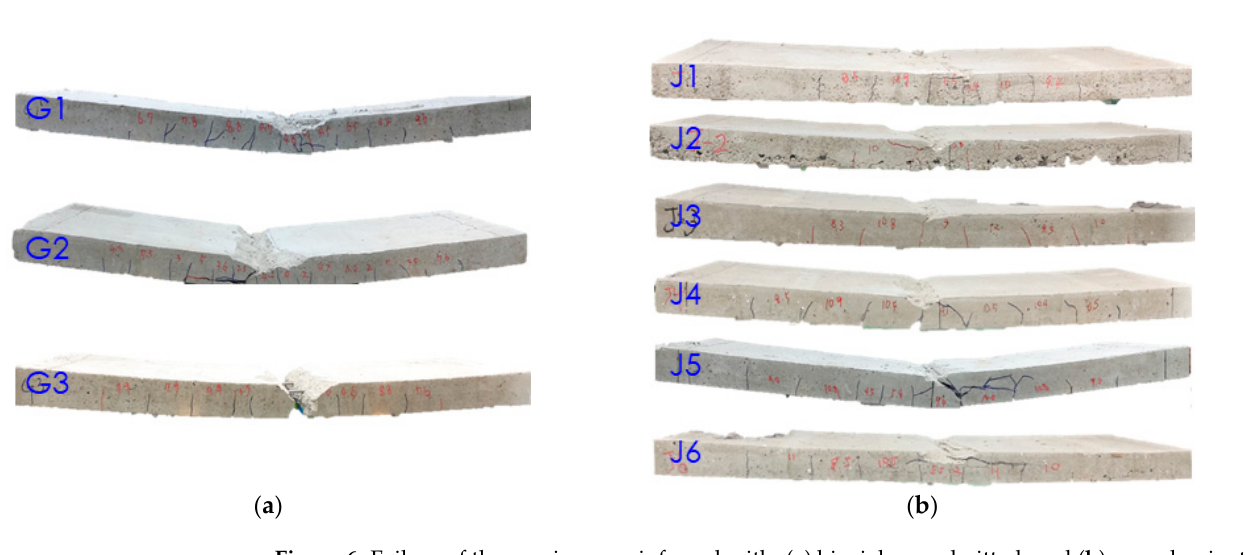
Figure 6. Failure of the specimens reinforced with: ( a ) biaxial warp-knitted; and ( b ) cross-laminate structured carbon grids.